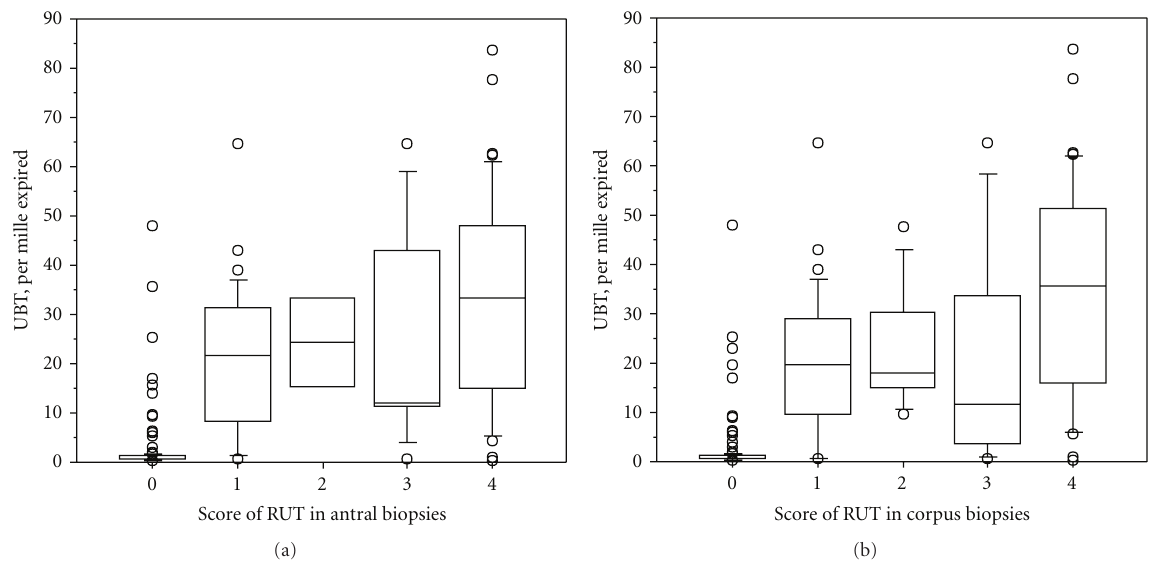
Figure 2: Boxplots (showing median and interquartile ranges) of relation between RUT score and histological score of H. pylori colonisation.